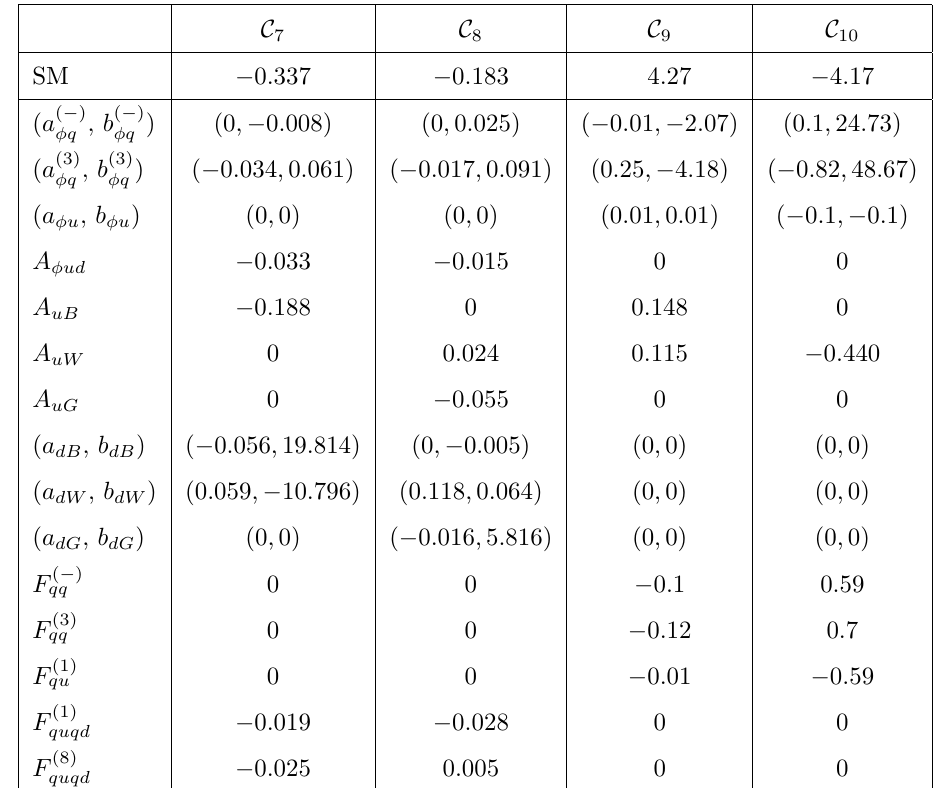
Table 5 . Matching contributions of SMEFT coefficients C ( m Z ) to the real part of the WET coefficients C ( m ) in MFV with up-alignment at one-loop level in the electroweak theory. The Z scale of new physics has been set to Λ = 1 TeV . Contributions to C the operators considered in this